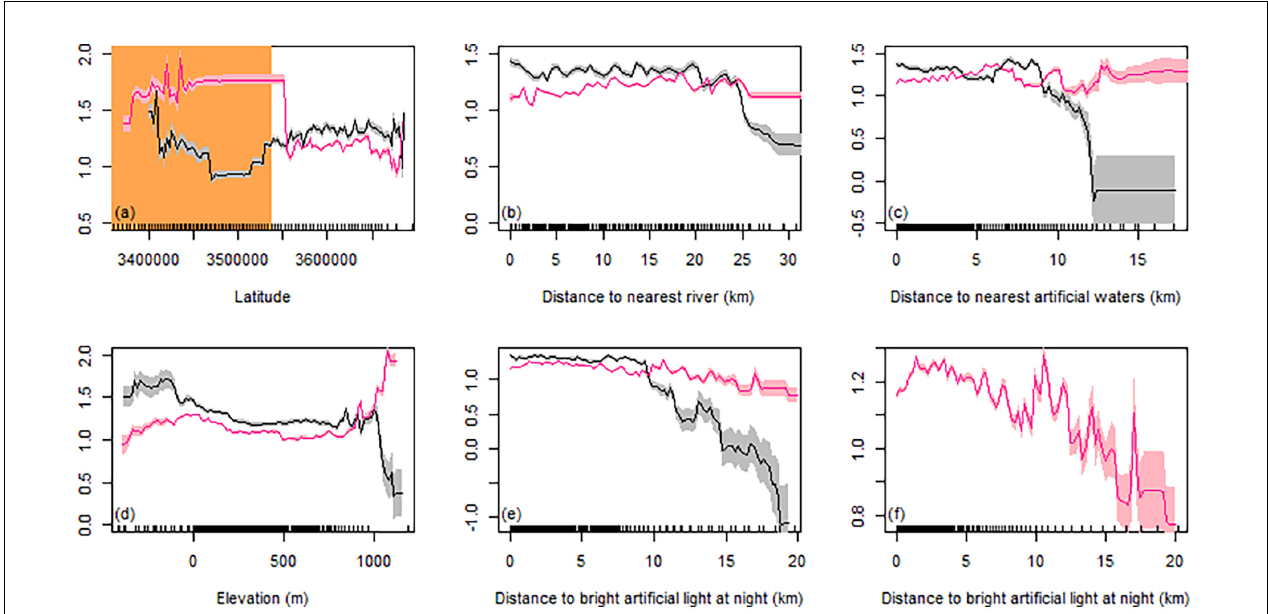
FIGURE 3 | Marginal responses of mean vertically integrated bird reflectivity (VIR; cm 2 /km 2 ) based on boosted regression tree (BRT) models in relation to (a) northing, (b) distance to rivers, (c) distance to artificial water reservoirs, (d) ground elevation, (e) distance to bright artificial light at night (ALAN) for both autumn and spring, (f) distance to bright ALAN only in the spring (note the change in the scale compared with e ). Autumn is depicted by a black line and a gray error area, representing 95% confidence intervals among ensemble of 20 BRT models. Spring is depicted by a dark pink line and a light pink error area. In (a) , the orange area represents the desert region latitudes, which encompass the southern half of